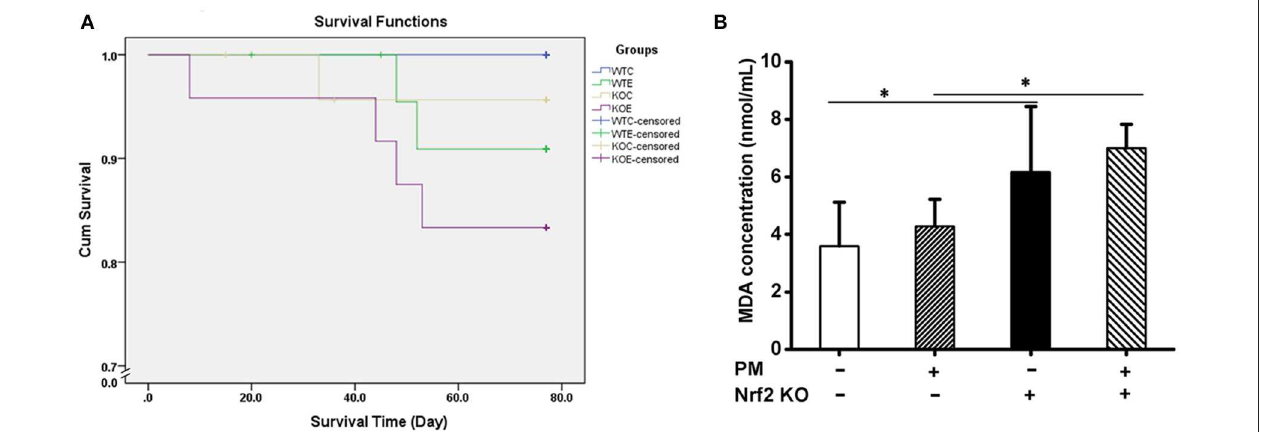
FIGURE 6 | Survival Plot and MDA contents in serum. For 11 weeks, 6–8-weeks C57/B6 mice, with or without Nrf2 knockout, were exposed to either filtered air or air containing particulate matter (PM), during which the dead animals were recorded, and the Kaplan-Meier survival plot was made. Serum from animals exposed to PM for 6 weeks were subjected to MDA assay with a commercially available kit (Solarbio, China, BC0025). N = 4 per group. *Statistically different between the two groups ( P < 0.05). (A) Kaplan-Meier survival plot of the animals. (B) MDA assay results of the animal